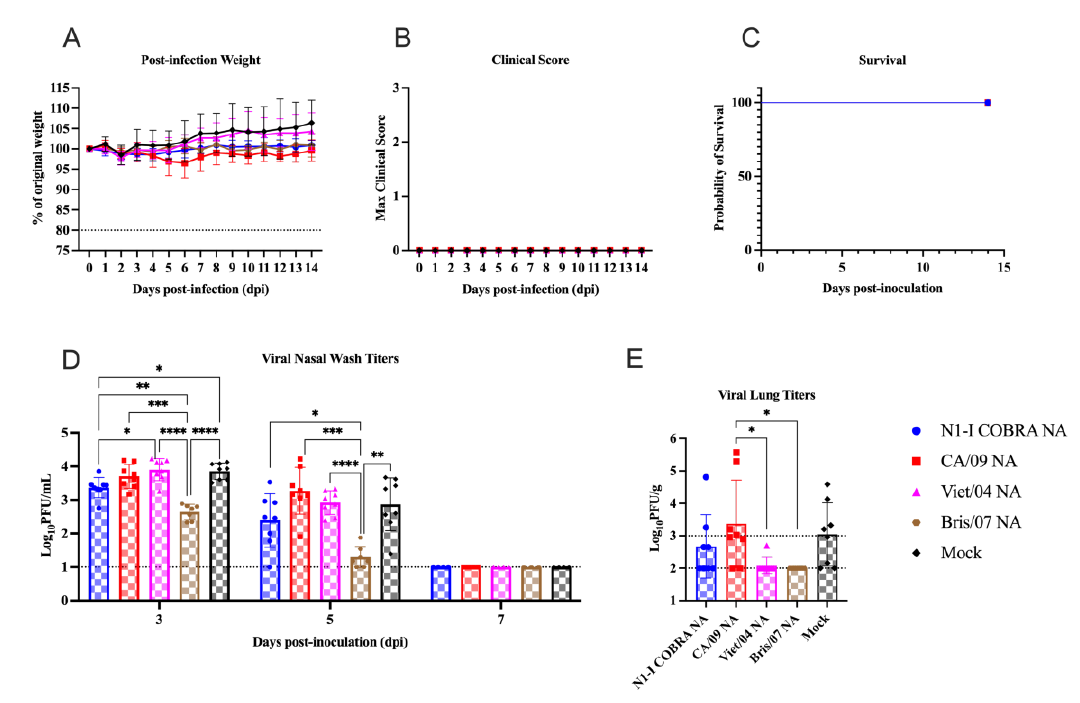
Figure 6. N1-I COBRA NA vaccine performed similarly to the Bris/07 NA vaccine in the naïve ferret model intranasally challenged with Bris/07 H1N1. ( A ) After infection with Bris/07, the weight during infection was normalized to the percentage of the original starting weight before infection. ( B ) The maximum clinical scores from the morning and evening checks were displayed with a score of three or greater indicating clinical endpoint. ( C ) Survival was determined after accounting for censored histopathology ferrets purposefully euthanized day 5 p.i. ( D ) The viral nasal wash titers for all vaccinated groups were determined through plaque assay and analyzed with a mixed effects model. ( E ) The viral lung titers were quantified by plaquing homogenized tissue each the upper and lower left lung lobes. The limit of detection (LOD; dashed line) was 1.0 log 10 (PFU/mL) and 2.0 log 10 (PFU/g) for the nasal wash titers and lung titers, respectively. The limit of quantification (dotted line) was 2.0 log 10 (PFU/mL) and 3.0 log 10 (PFU/g) for the nasal wash titers and lung titers, respectively. All error bars represent standard deviation. Adjusted p -value: * ≤ 0.05, ** ≤ 0.01, *** ≤ 0.001, **** ≤ 0.0001.